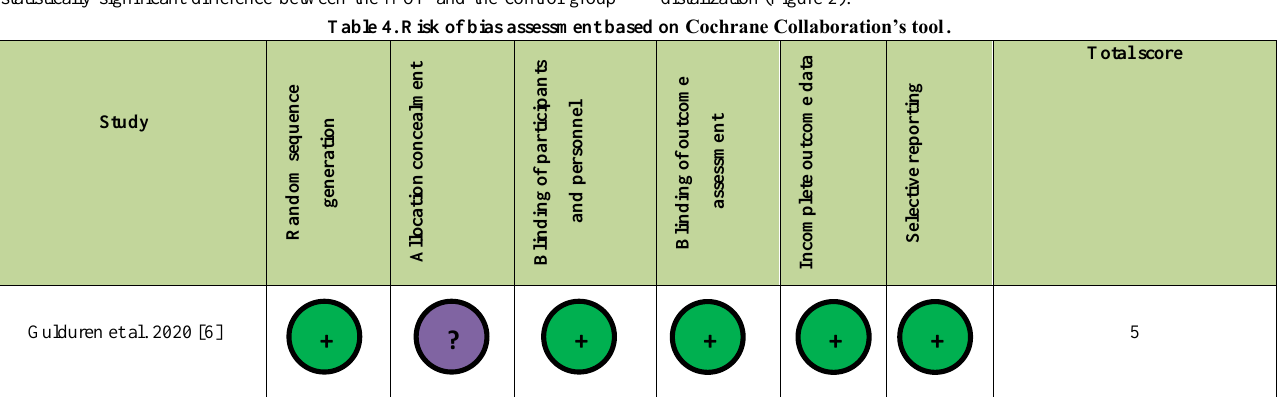
Table 4. Risk of bias assessment based on Cochrane Collaboration’s tool.